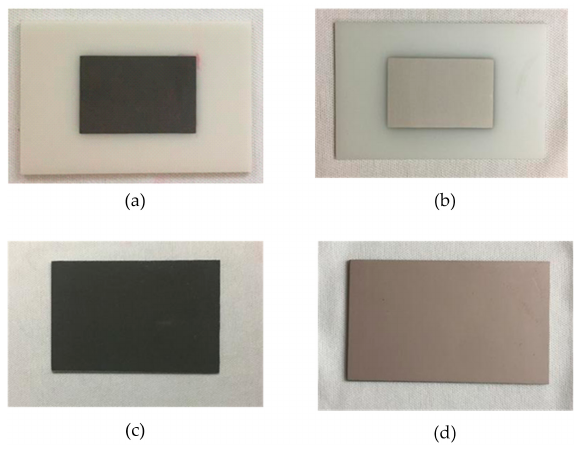
Figure 7. Patch antenna-type temperature sensor after each step of the fabrication process: ( a ) printed radiation patch; ( b ) sintered radiation patch; ( c ) printed metal layer; ( d ) sintered metal layer.